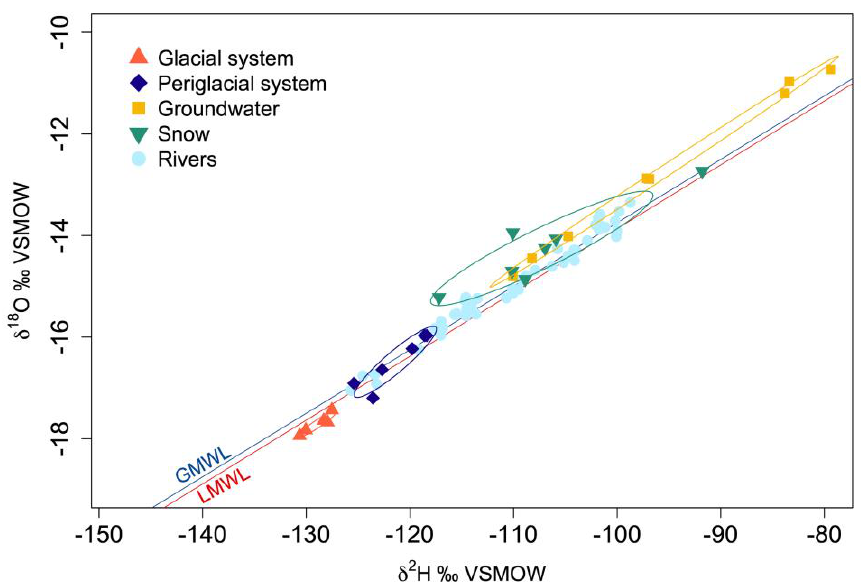
Figure 3. Stable isotope ( δ 18 O and δ 2 H) scatter plot of rivers and water sources. The blue line represents the Global Meteoric Water Line (GMWL) according to Craig’s equation [53]. The red line represents the Local Meteoric Water Line (LMWL), was constructed with our data at 33 ◦ S and follows the equation: δ 2 H = 7.9874 × δ 18 O + 10.892 ( R 2 = 0.9974), close to the LMWL at 33 ◦ S reported by Taucare et al.: